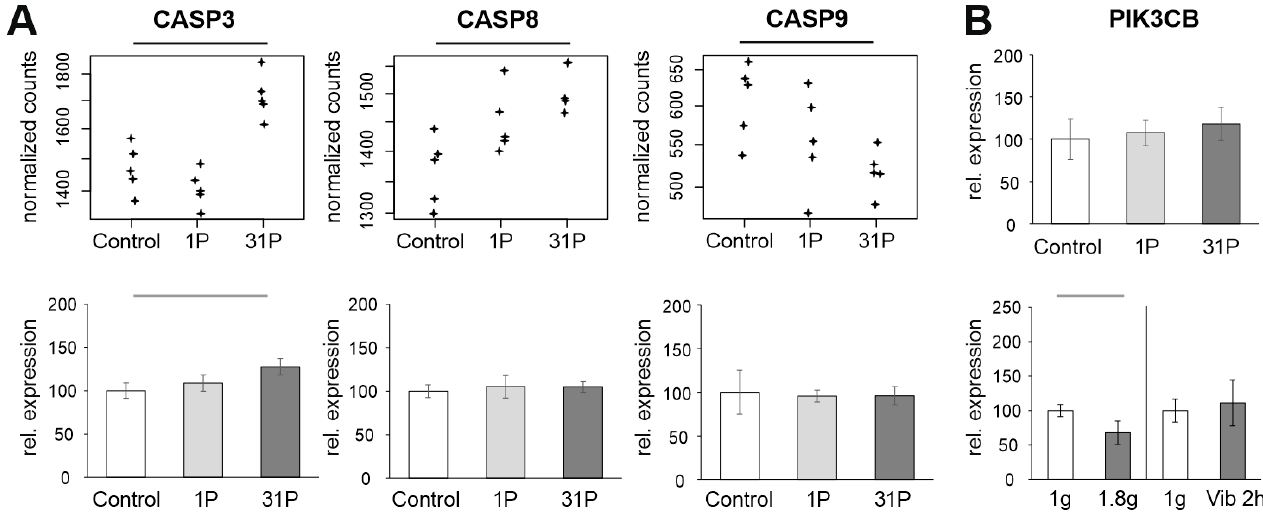
Figure 7. Analysis of apoptosis-related genes in PF samples. ( A ): Normalized PF RNAseq counts and qPCR ratios of the three apoptosis-related genes CASP3 , CASP8 and CASP9 . ( B ): PIK3CB qPCR expression relative to the controls of the PF, hypergravity and Vibraplex experiment. Black and grey bars on top of the graph indicate adjusted and nominal significant ( p < 0.05) differential expression, respectively.